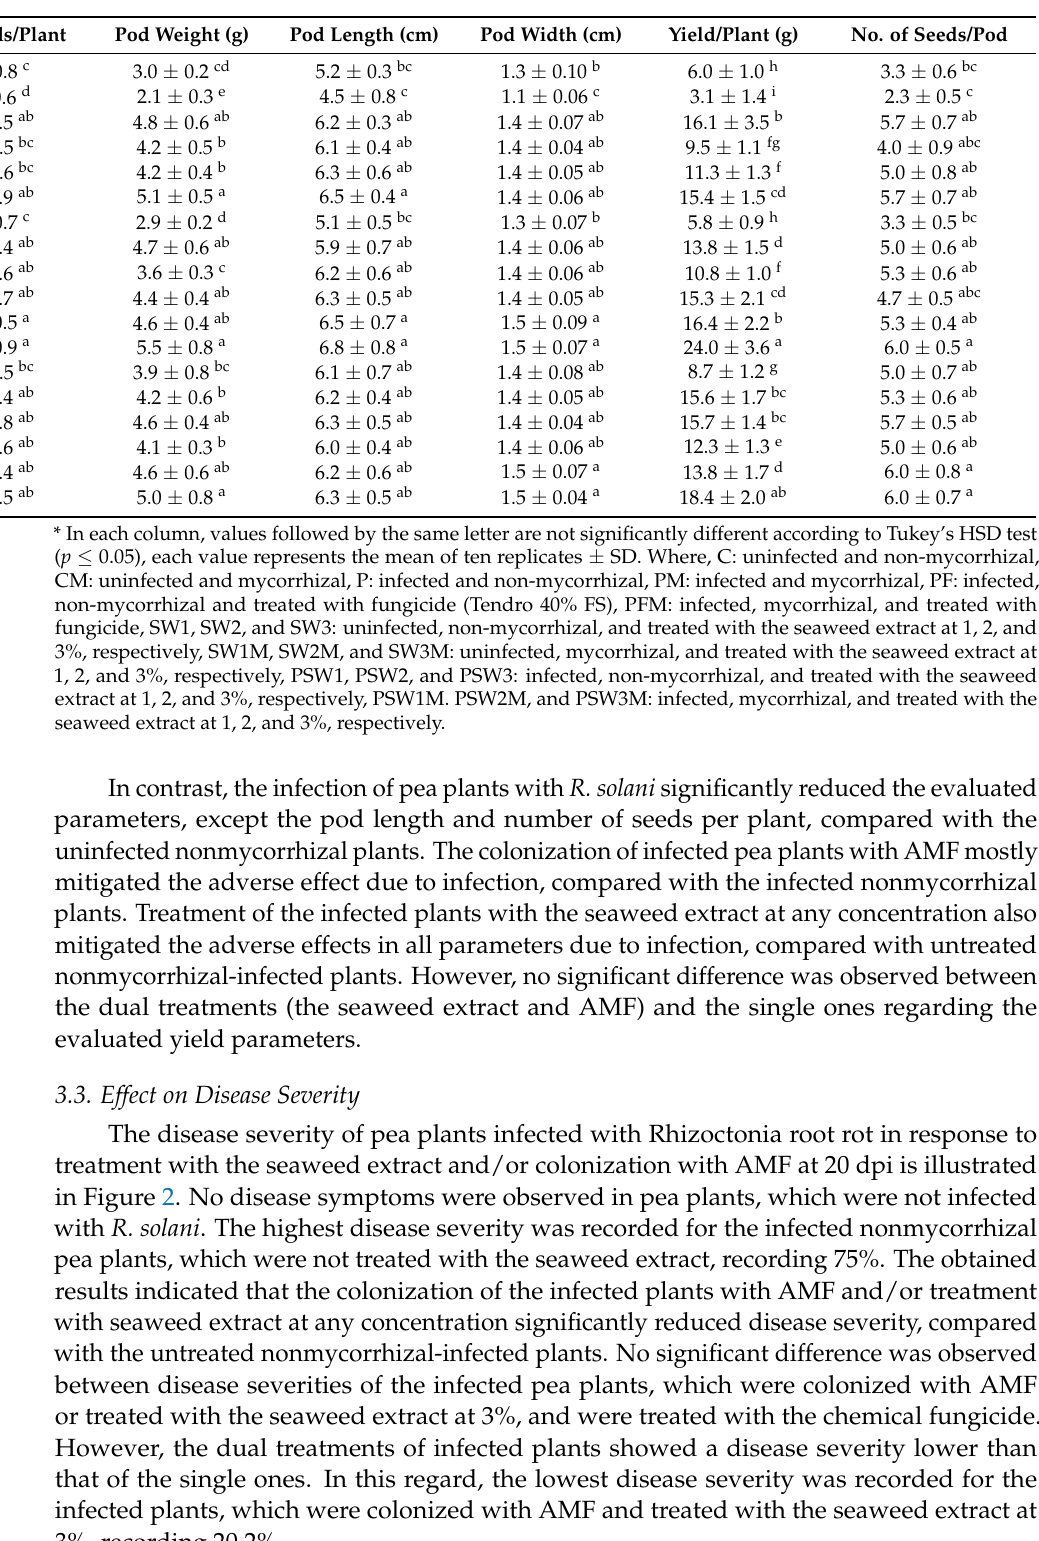
Table 4. Mean yield and its components of pea plants (cv. Master-B) infected with Rhizoctonia root rot in response to treatment with the seaweed extract and/or colonization with arbuscular mycorrhizal fungi, at 40 days post-inoculation